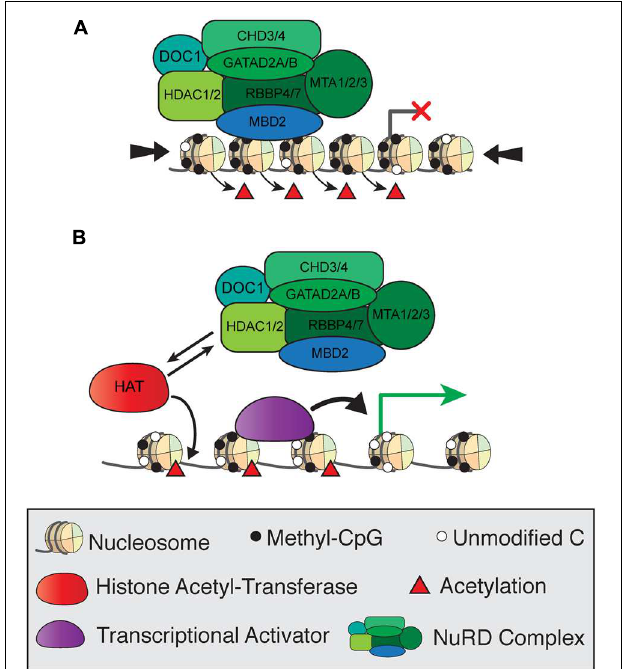
FIGURE 4 | Simplified model of transcriptional regulation by MBD2 and NuRD. (A) MBD2 binds to mCG-dense regions as a component of the NuRD complex, which induces histone deacetylation and chromatin compaction (large arrows) leading to transcriptional silencing. (B) At transcriptionally active sites, MBD2/NuRD is replaced by histone acetyltransferases and activating transcription factors to induce histone acetylation and open, active